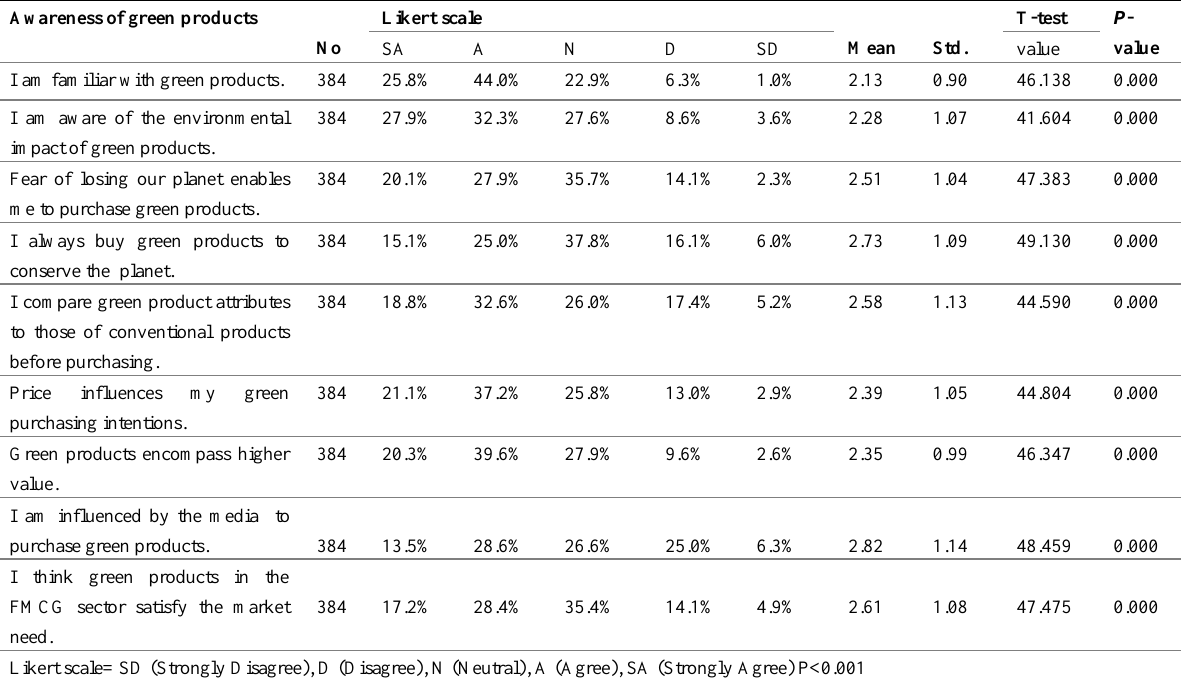
Table 5: Participants’ awareness of green products